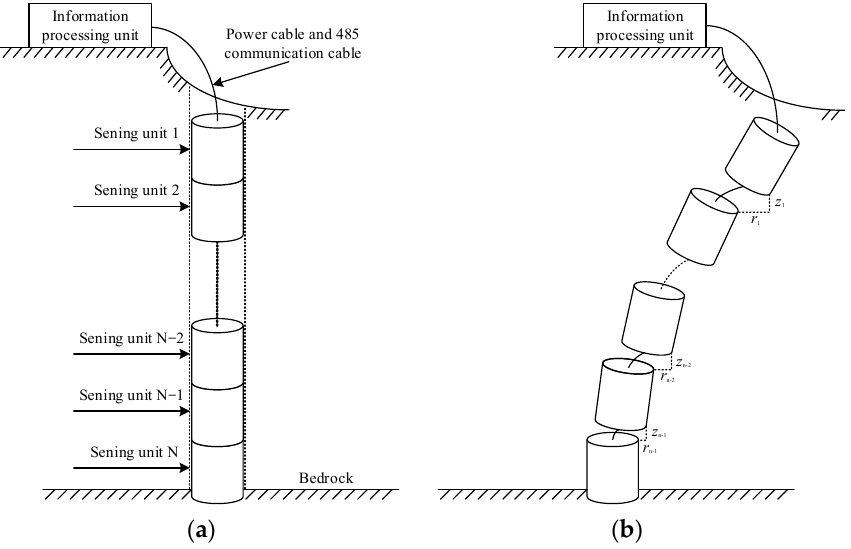
Figure 2. Schematic diagram of the structure of the sensing unit.